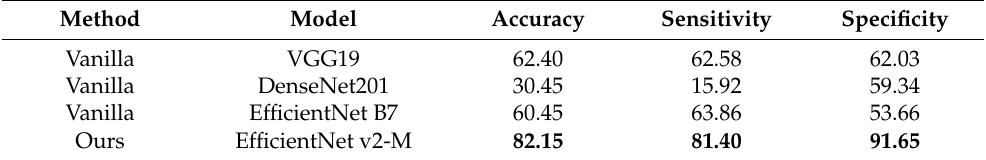
Table 11. Performance comparison of three-class classification on validation set of NIH data set (%). Method Model Accuracy